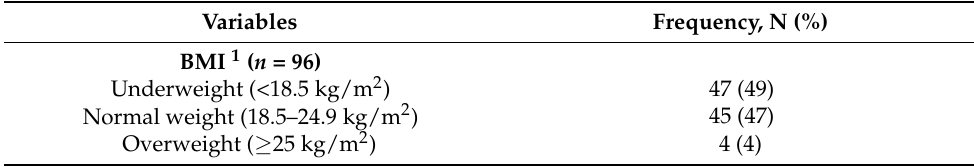
Table 2. Clinicopathological characteristics of HCC